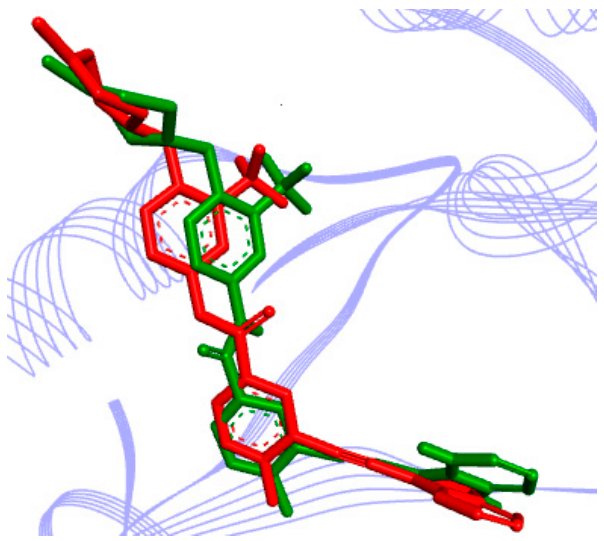
Figure 5. Result of validation for a known potent RIPK2 inhibitor, ponatinib, inside the enzyme active site (derived from PDB ID 4C8B), obtained with the AutoDock software: in red, the crystallographic pose; in green, the top-ranked docking pose. Inhibitor is represented in stick, whereas the RIPK2 active site is represented as a Ribbons diagram (in lines).